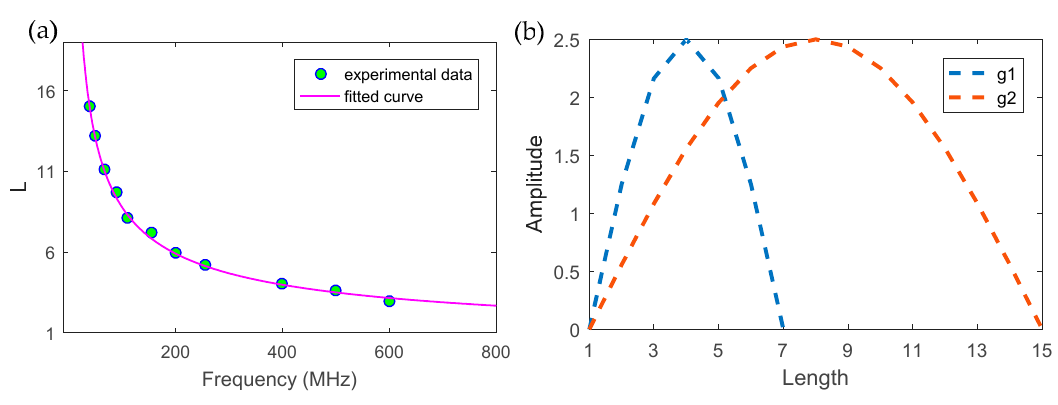
Figure 8. ( a ) Experimental data for fitting Equation (17); ( b ) the two structural elements of the second scale-range filter in Equation (16).